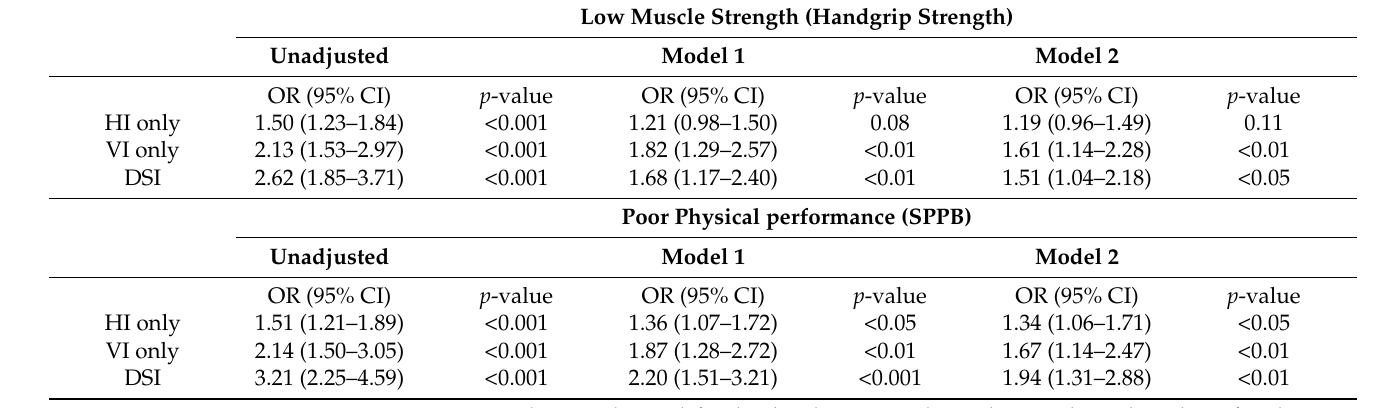
Table 4. Association between sensory impairment and low physical function (longitudinal analysis). Low Muscle Strength (Handgrip